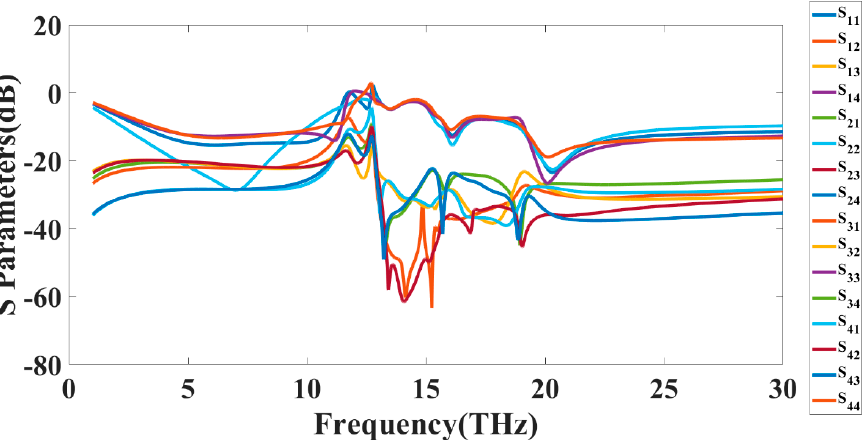
Figure 12. Calculated reflection coefficient of the proposed four-port structure. S parameters are calculated by exciting all four ports.